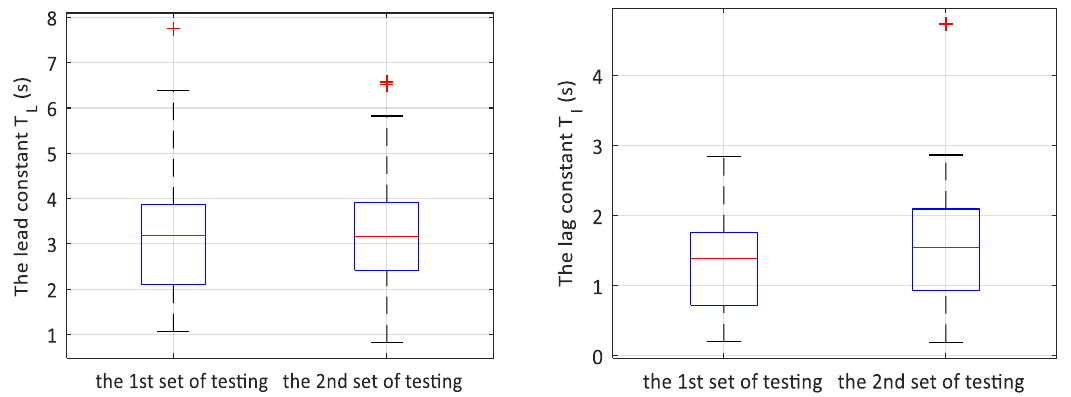
Figure 9. The box graphs for lead T L and lag T I time constants.